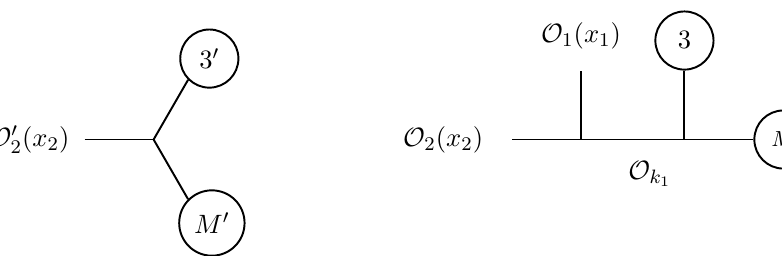
Figure 10 . The desired M -point conformal block (right), in which external (internal) operators ) have conformal dimensions ∆ O a ( x a ) ( O k a related to (5.31), in which external (internal) operators O 0 ∆ 0 = ∆ for 2 ≤ a ≤ M ( ∆ 0 a − λ a a